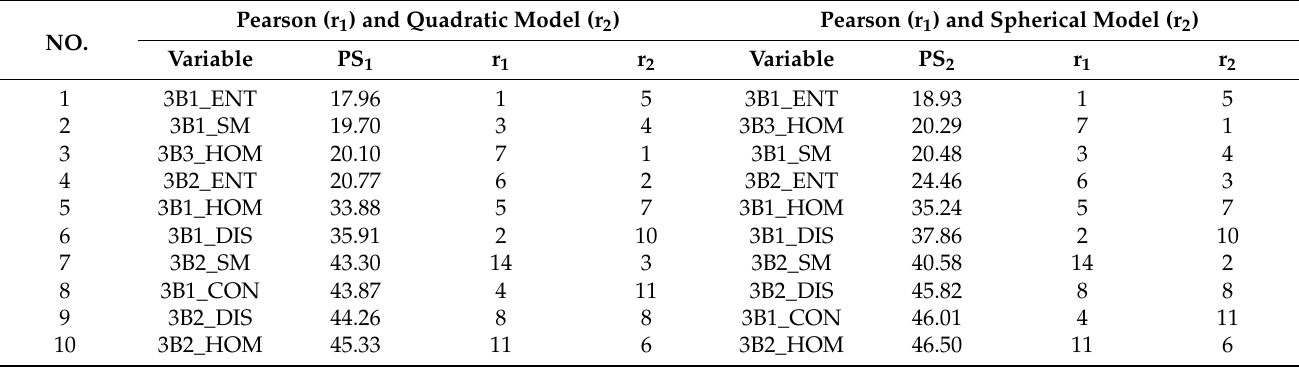
Table 4. PS values of top 10 variables extracted from GF-1 images.